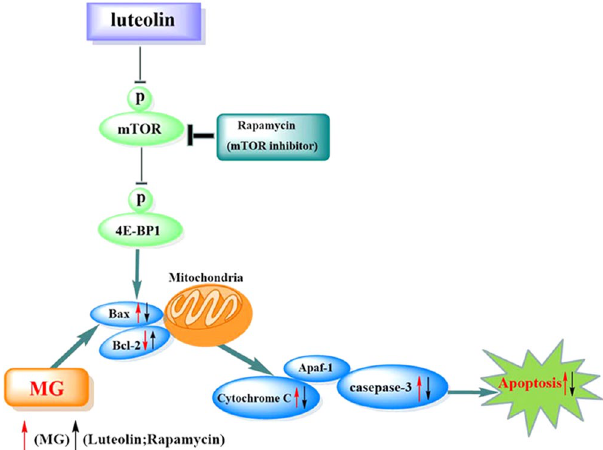
Figure 5. A proposed model of molecular targets of Luteolin (Lut) in preventing MG-induced apoptosis. Our study found that Lut prevents MG-induced apoptosis by decreasing protein phosphorylation of mTOR, and 4E-BP1 in PC12 cells. Furthermore, our study also confirmed the mTOR/4E-BP1 signaling pathway modulates apoptosis and regulates the expression of the pro-apoptotic protein Bax in PC12 cells. This suggests that Lut prevented MG-induced cell apoptosis and decreased the expression of the pro-apoptotic Bax protein and Cyt C and casepase-3 through inhibiting mTOR/4E-BP1 signaling